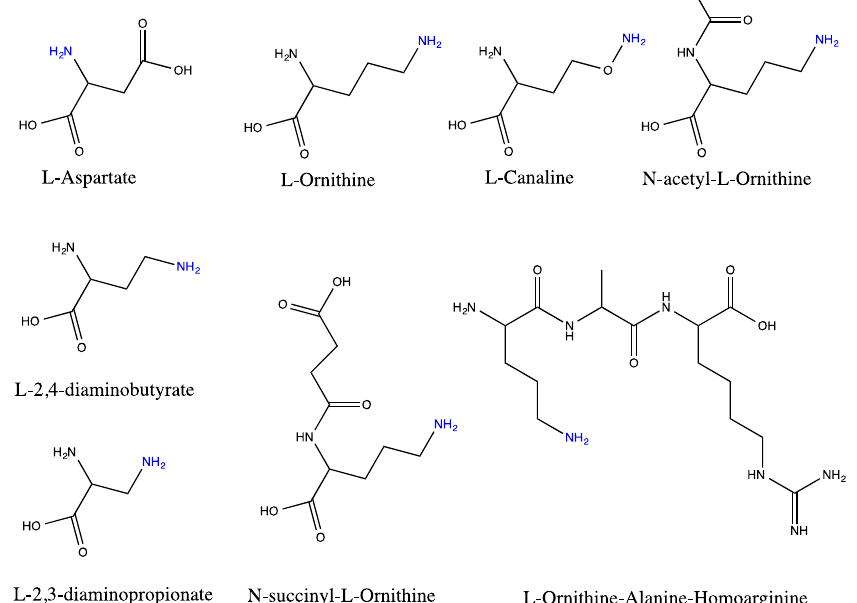
Figure 3. Schematic drawing of the structures of substrates of N -transcarbamylases. The nitrogen amino group, labeled as blue color, is the acceptor of the carbamyl group of CP during the transcarbamylation reaction catalyzed by N -transcarbamylases.